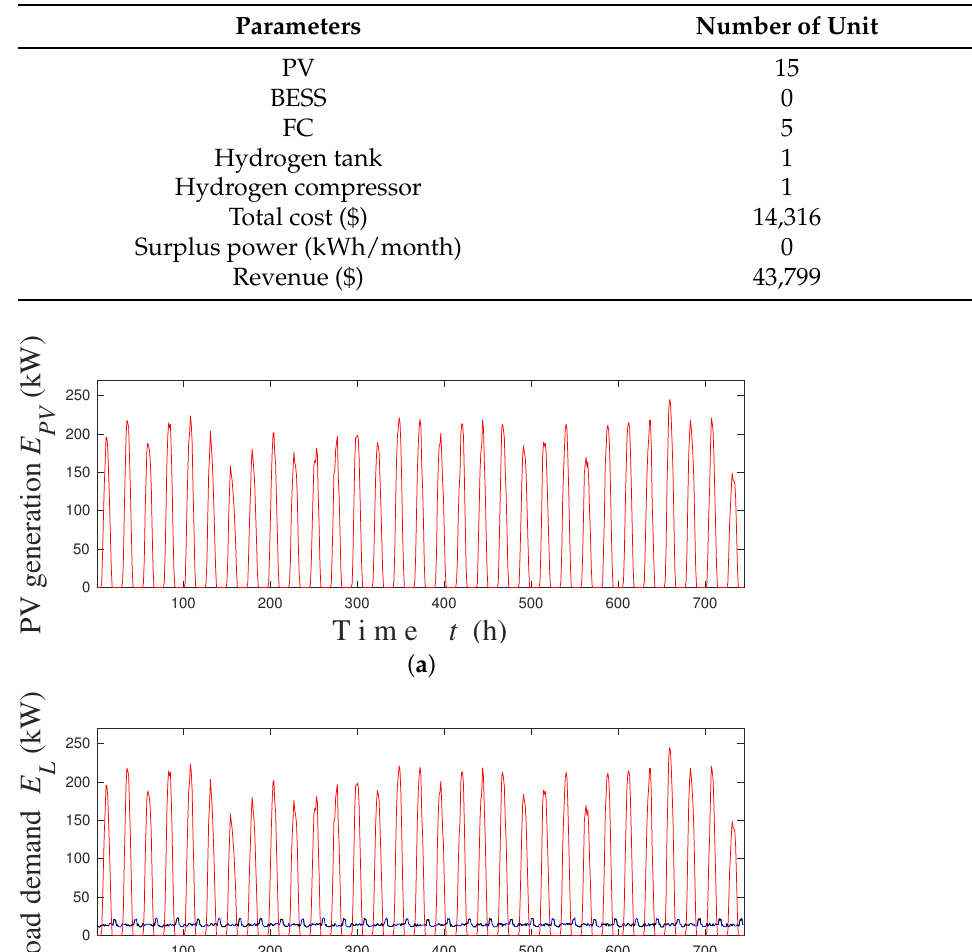
Table 13. Simulation results of case 2.